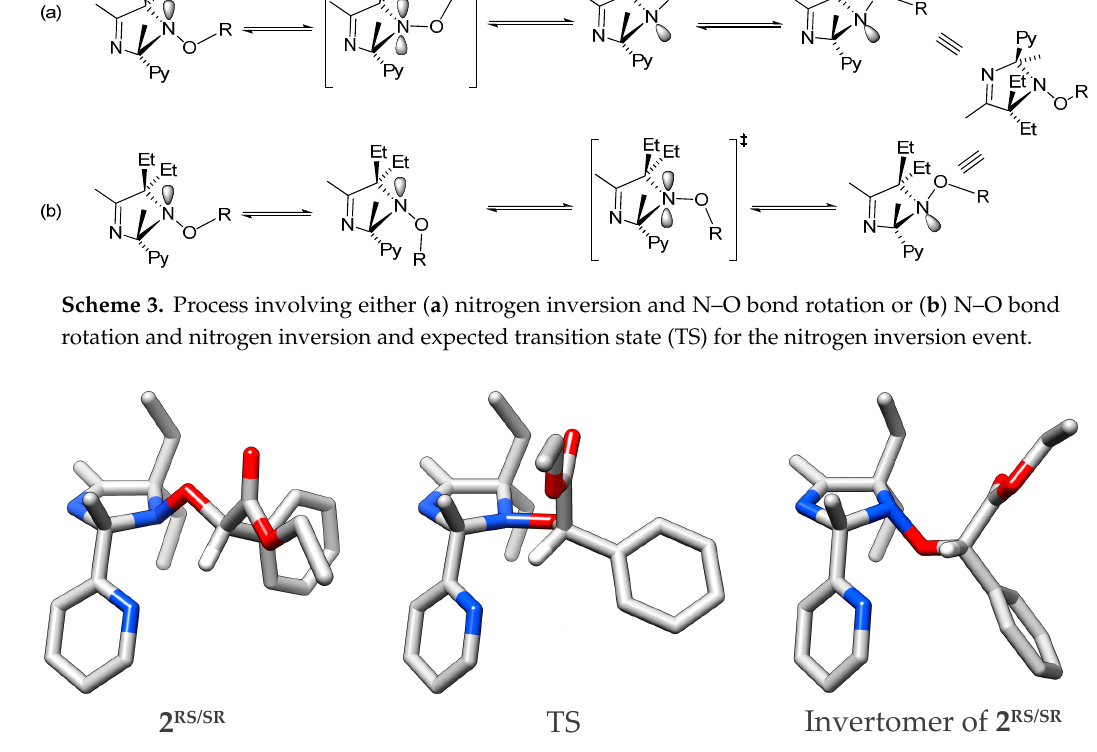
Figure 4. Geometries of the 2 RS/SR invertomers and the transition state of nitrogen inversion calculated by Density Functional Theory/Perdew-Birke-Ernzerhof (DFT/PBE)/ Λ 01.